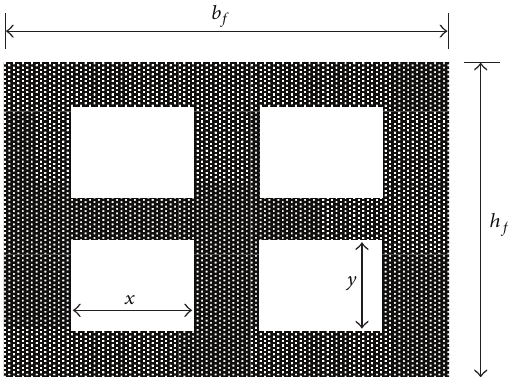
Figure 9: Dimensions of a GFRP plate and its openings.